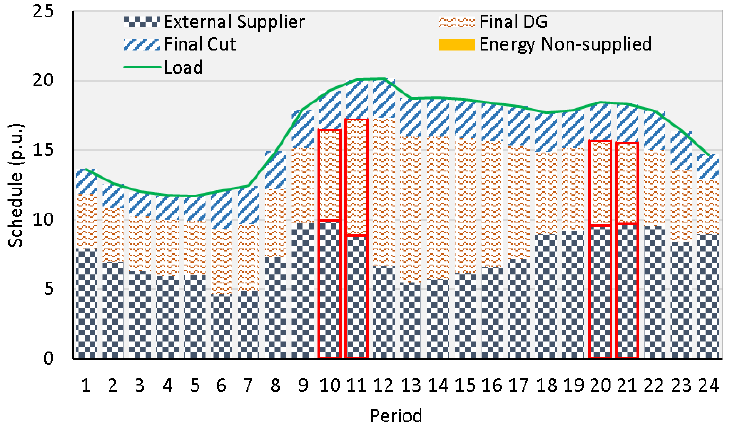
Figure 6. Scheduling after aggregation and remuneration processes.